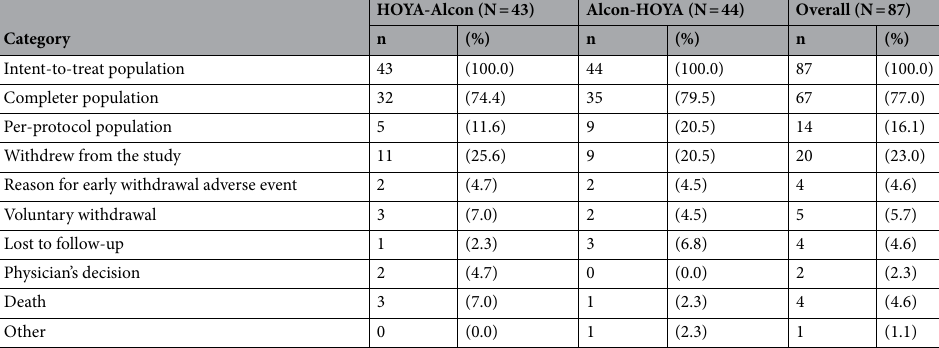
Table 2. Subject disposition (all randomized subjects). Percentages are based on the number of randomized subjects in the sequence. The intent-to-treat population consists of all randomized subjects who have at least one IOL implanted. The completer population consists of all the ITT subjects who have both IOLs implanted with follow-up through the primary assessment time point. The per protocol population includes all subjects who are in the completer population with no significant protocol deviations.